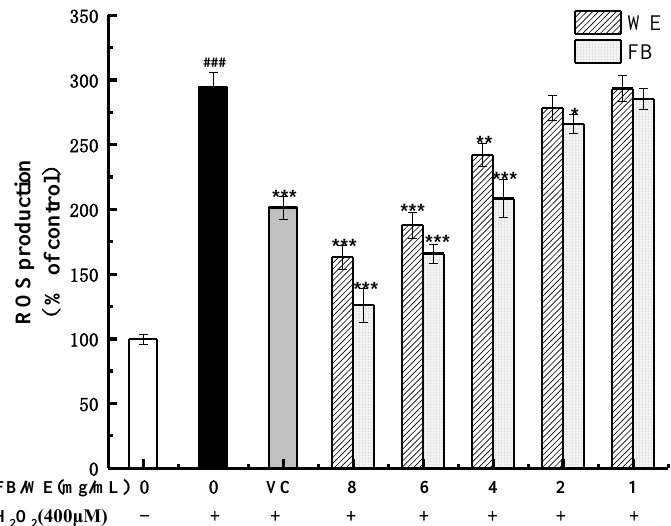
Figure 6. Effects of the WE and FB on H 2 O 2 -introduced ROS production in HaCaT cells. The cells were cultured with different concentrations (8, 6, 4, 2 and 1 mg/mL) of WE and FB for 24 h and then stimulated by 400 μM of H 2 O 2 for 2 h. The ROS content was detected by DCFH-DA and examined by a fluorescence enzyme reader. In the picture: VC stands for Vitamin C, and the concentration is 2 μg/mL. Significance: ### p < 0.001 vs. the control group. *** p < 0.001, ** p < 0.01 and * p < 0. 05 vs. the H 2 O 2 -treated group. Data shown as the mean ± S.D. ( n = 5).